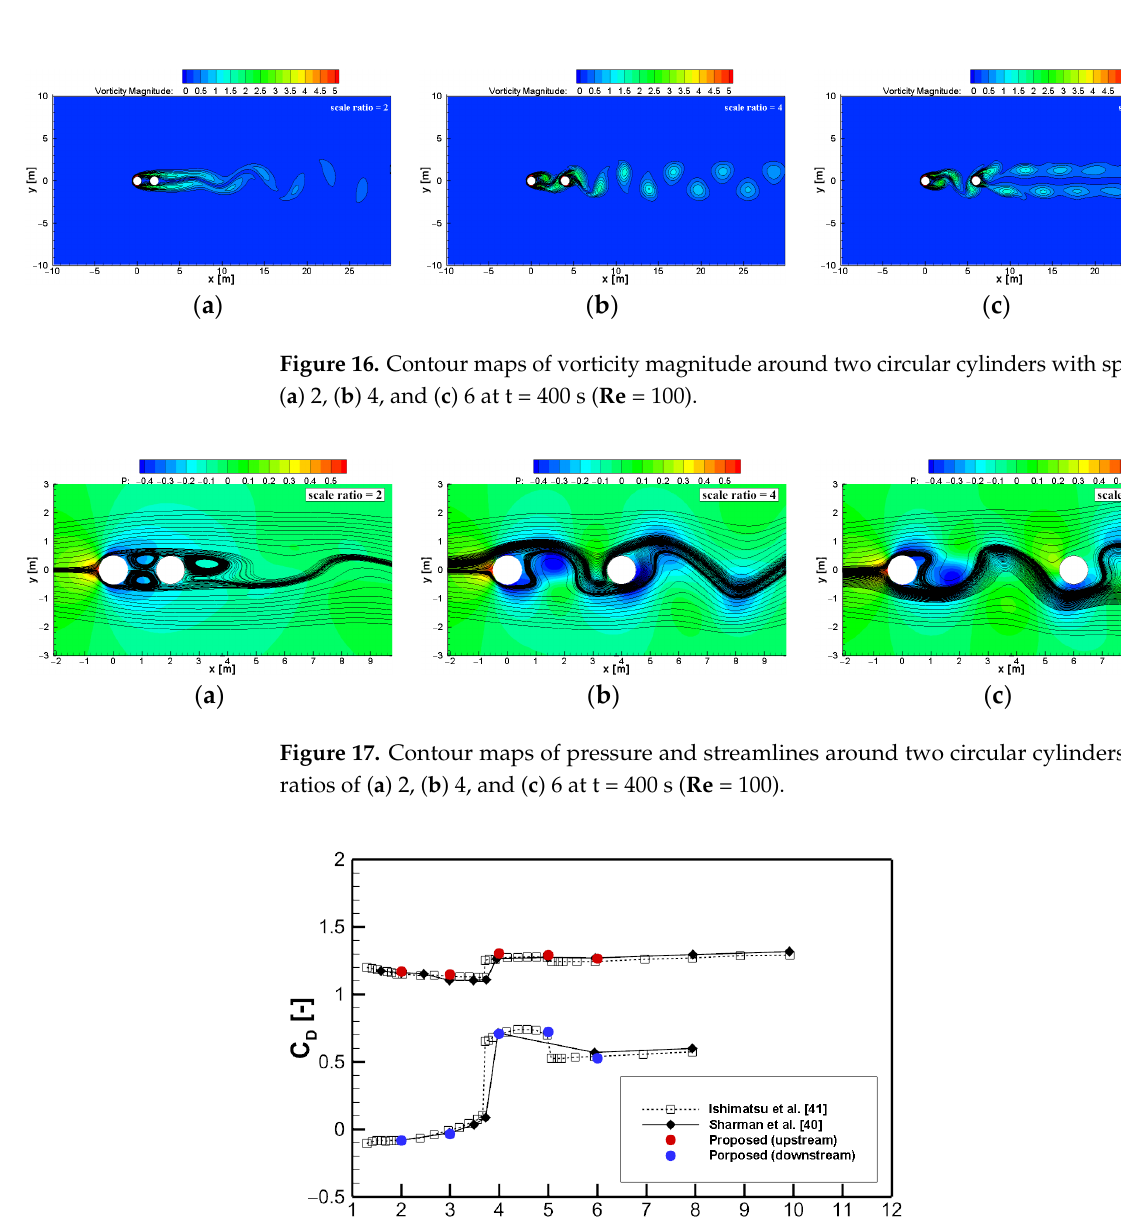
Figure 18. Comparison of drag coefficients for two circular cylinders in tandem arrangement ( Re = 100).